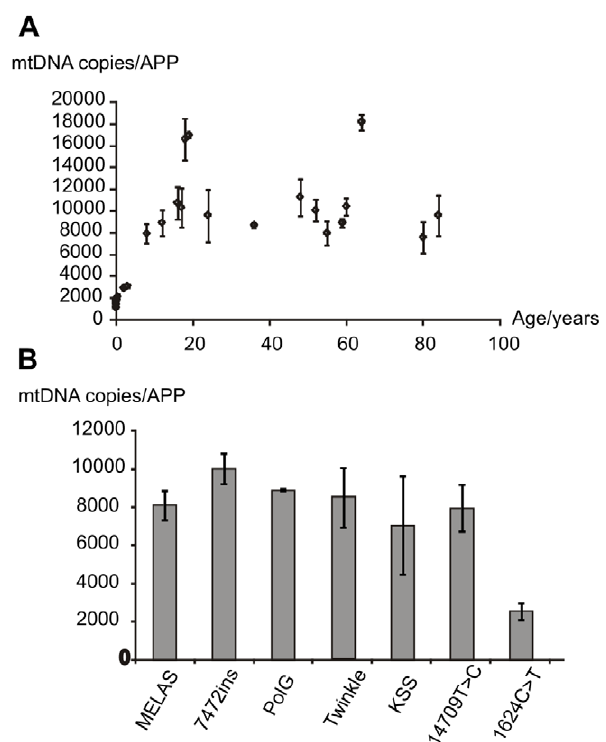
Figure 6. Increase in human heart mtDNA copy number during childhood correlates with the changes in molecular organiza- tion. (A) Five-fold increase in mtDNA copy number from newborns to teen-age. As with the mtDNA organization, individual variation can be seen in adults. Standard deviation represents three independent measurements of the same samples. (B) No significant difference in mtDNA copy number of PolG compound mutant patient heart, indicating that existence of dimeric mtDNA molecules is independent of copy number and quantity of branched mtDNA structures. With the exception of KSS, the mtDNA copy numbers were determined by qPCR against a single copy nuclear gene (APP). Because of the location of the cytb amplicon in the deleted region, copy number of the KSS was determined by Southern hybridization and absolute numbers were estimated by comparison with two control samples that were quantified also by qPCR (Figure S1, Text S1).